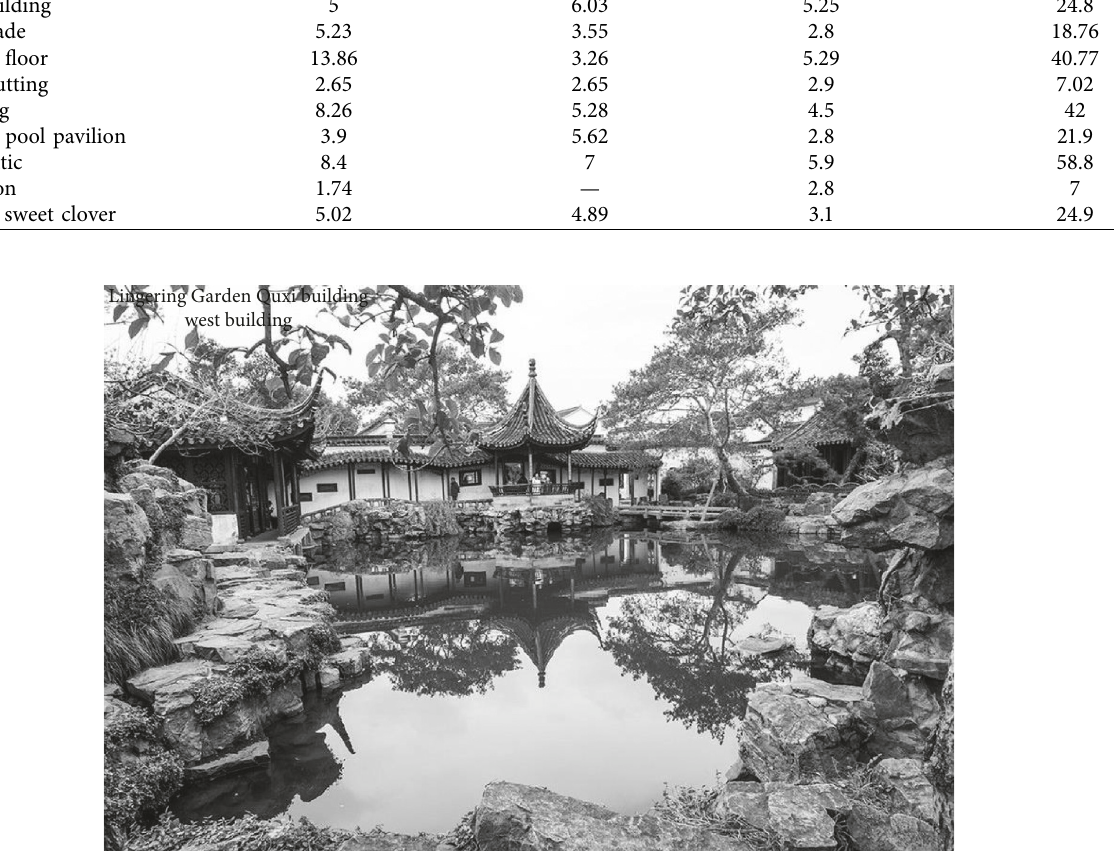
Figure 1: Landscape diagram of Liu Yuan. Table 3: Scale quantification of Liu Yuan